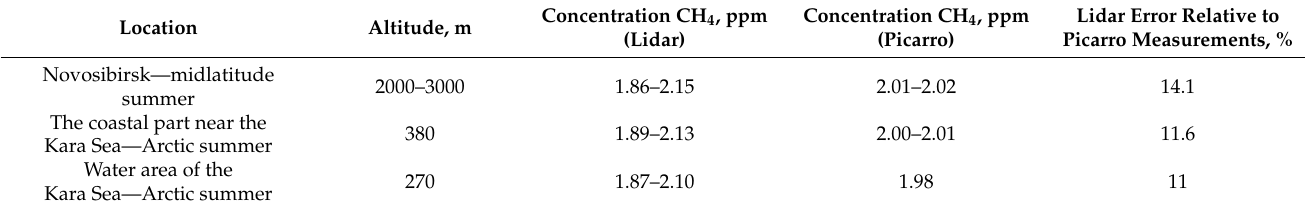
Table 5. Results of lidar measurements at selected locations and comparison with the results of in situ measurements of the Picarro gas